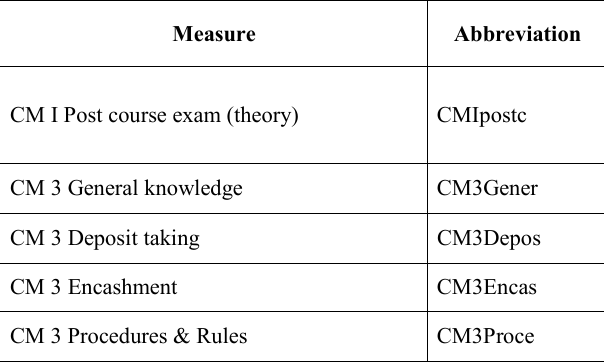
Table 5: Criteria to measure